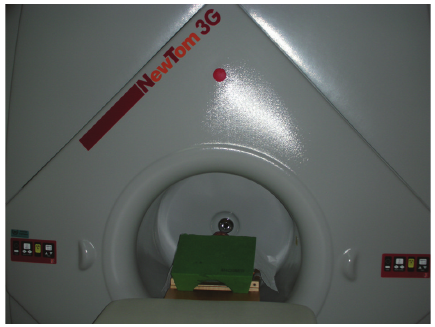
Figure 1: Newtom cone beam 3D imaging equipment.